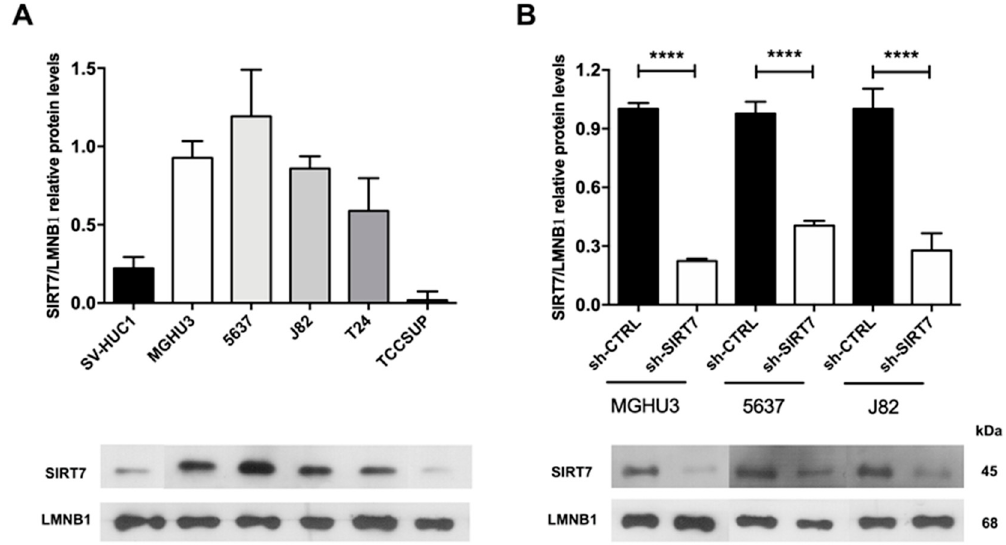
Figure 3. SIRT7 expression in bladder cancer cell lines. Expression of SIRT7 nuclear protein ( A ) in bladder cancer cell lines by Western blot; results are representative of three independent experiments with mean ± SD. Confirmation of SIRT7 knockdown in MGHU3, 5637 and J82 cell lines at nuclear protein level ( B ) by Western blot; **** p < 0.0001, results are representative of three independent experiments with mean ± SD.